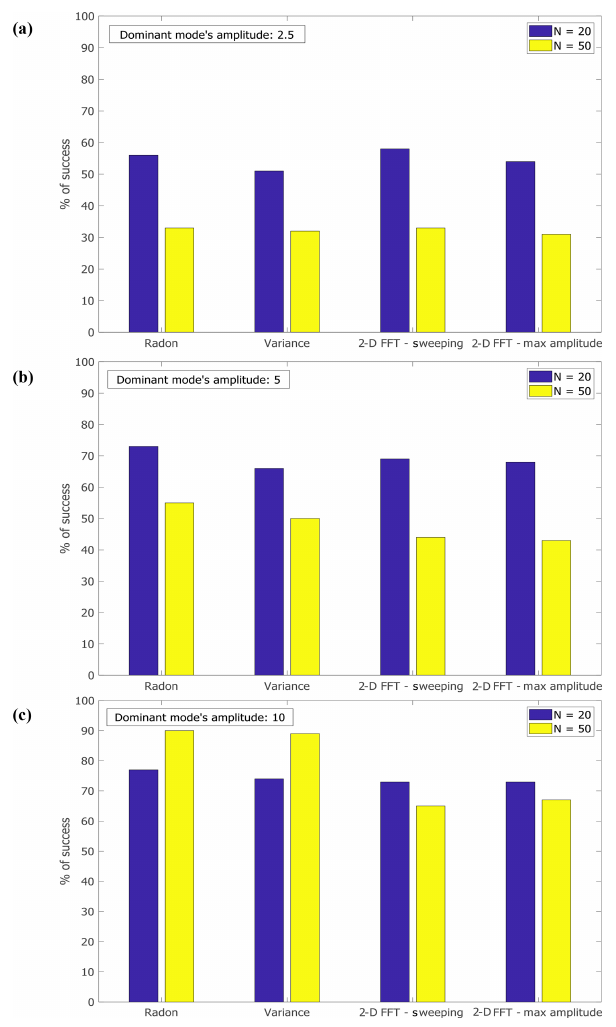
Figure 3. The percentage of success of each variant of the methods for dominant input mode’s amplitude of 2.5 (a) , 5 (b) and 10 (c) for both N = 20 and N = 50.